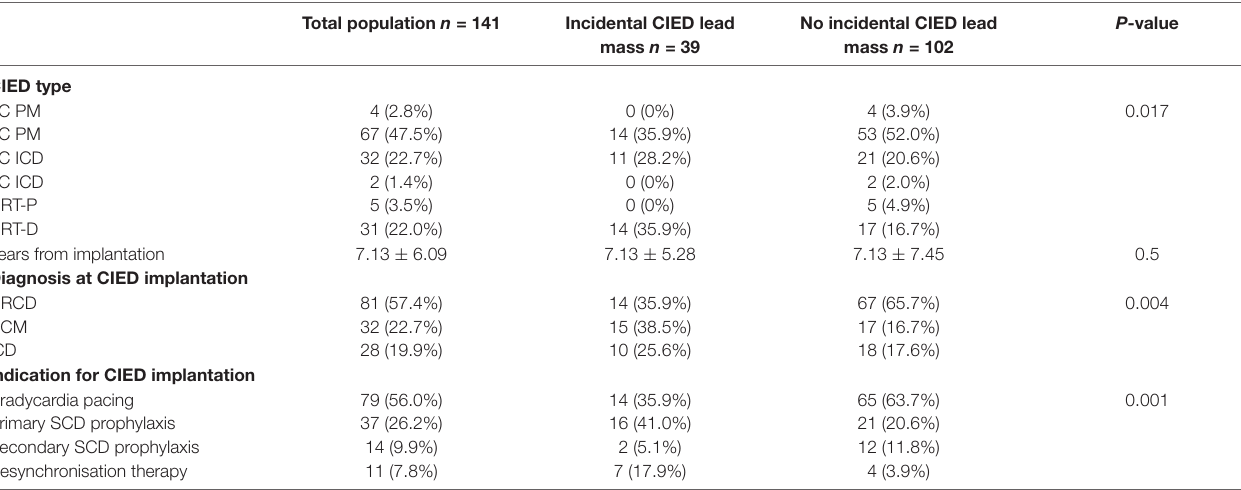
FIGURE 2 | Distribution of the presence (A) presence of anticoagulation and (B) type of anticoagulant in patients with incidental non-infectious CIED lead masses and in patients with non-suspicious leads. NOAC, novel oral anticoagulant. TABLE 2 | Cardiac implantable electronic device (CIED) characteristics and initial CIED